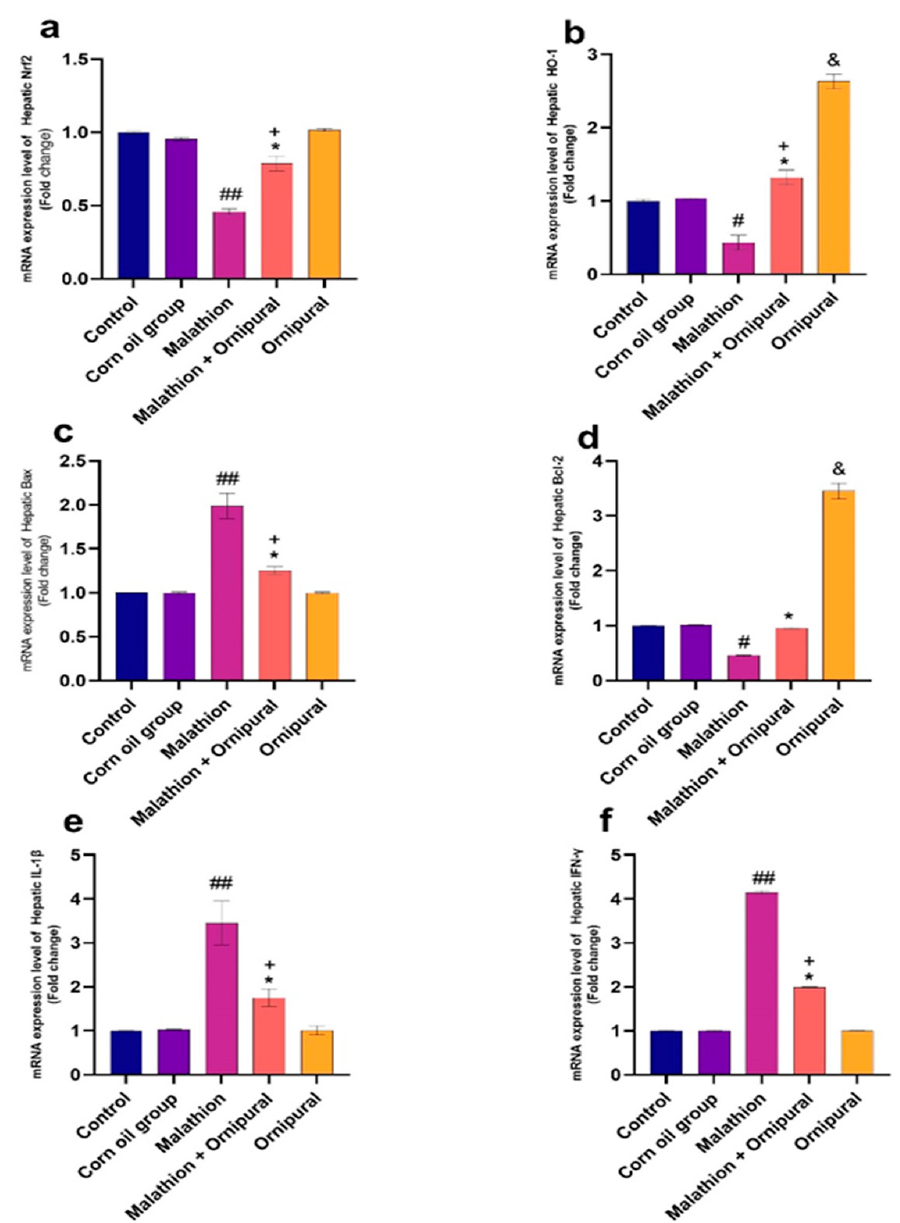
Figure 3. Modulatory effect of Ornipural ® against malathion-induced inflammation in hepatic tissue